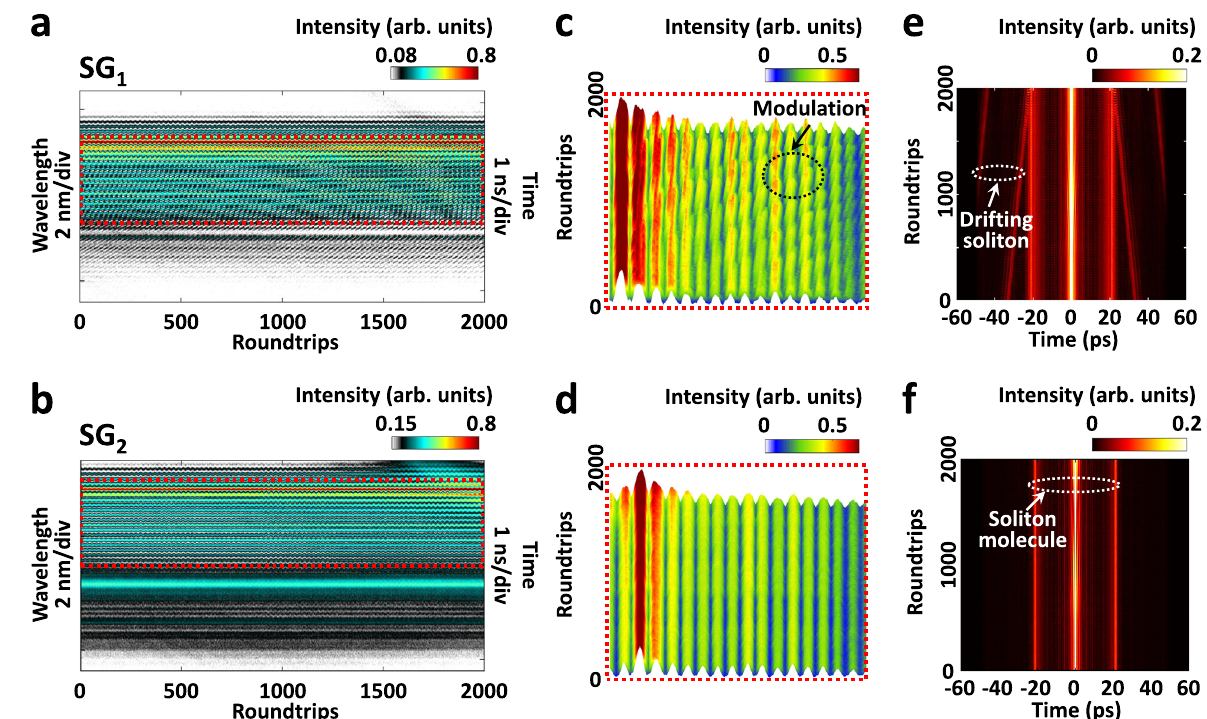
Fig. 2 | Speckle-resolved spectral-temporal dynamics of 3D dual-soliton mole- cules. a , b Spectral evolutions of the 3D dual-soliton molecule in two different speckle grains. c , d Close-ups of the spectral evolutions, as indicated by the red